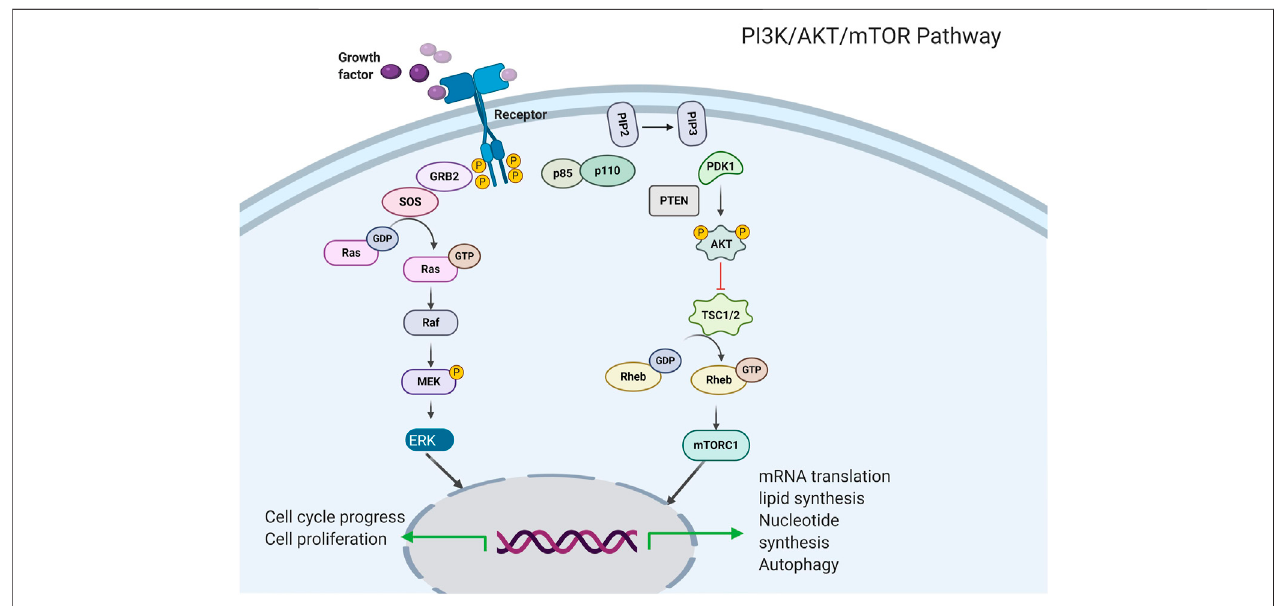
FIGURE 2 | Intracellular signaling via the PI3K/AKT/mTOR